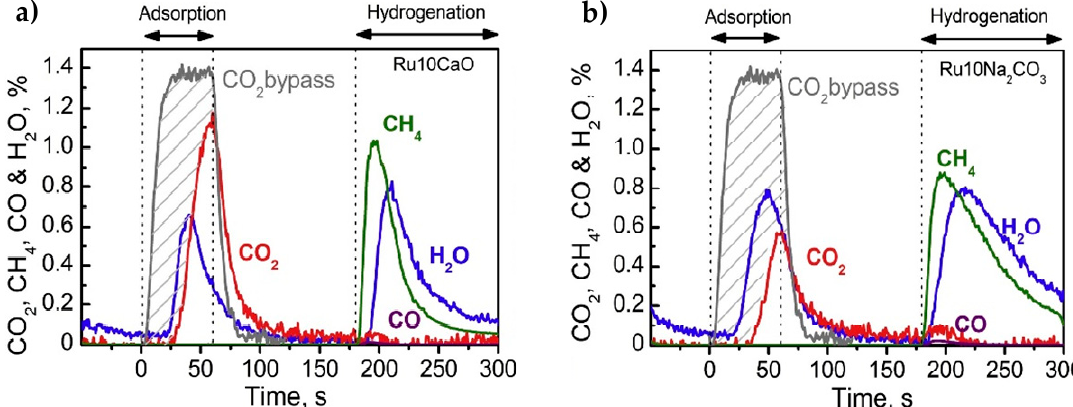
Figure10. CO 2 , H 2 O,CH 4 andCOconcentrationprofilesduringoneCO 2 adsorptionandhydrogenation Figure 10. CO 2 , H 2 O, CH 4 and CO concentration profiles during one CO 2 adsorption and cycle at 370 ◦ C with ( a ) Ru10CaO and ( b ) Ru10Na 2 CO 3 samples. Reproduced with permission from hydrogenation cycle at 370 °C with ( a ) Ru10CaO and ( b ) Ru10Na 2 CO 3 samples. Reproduced with ref. [24]. Copyright 2019 Elsevier. permission from ref. [24]. Copyright 2019 Elsevier.